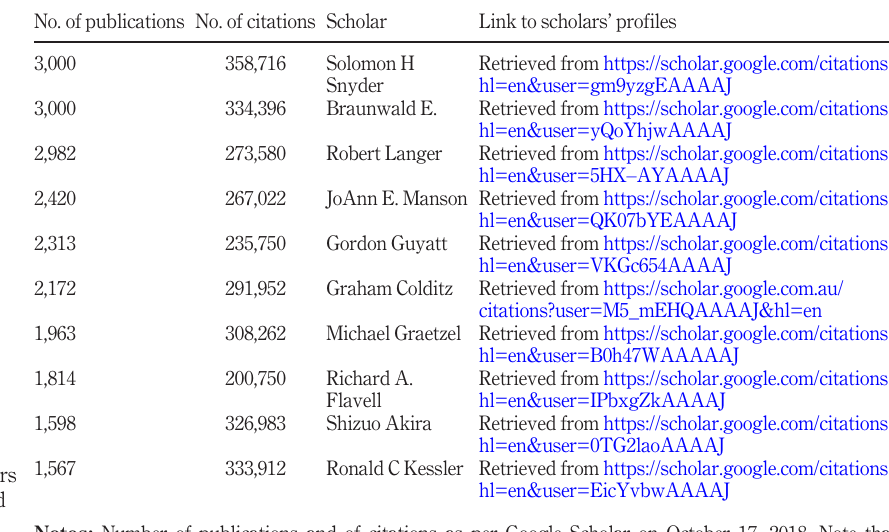
Table I. Examples of scholars who have published more than one thousand scholarly